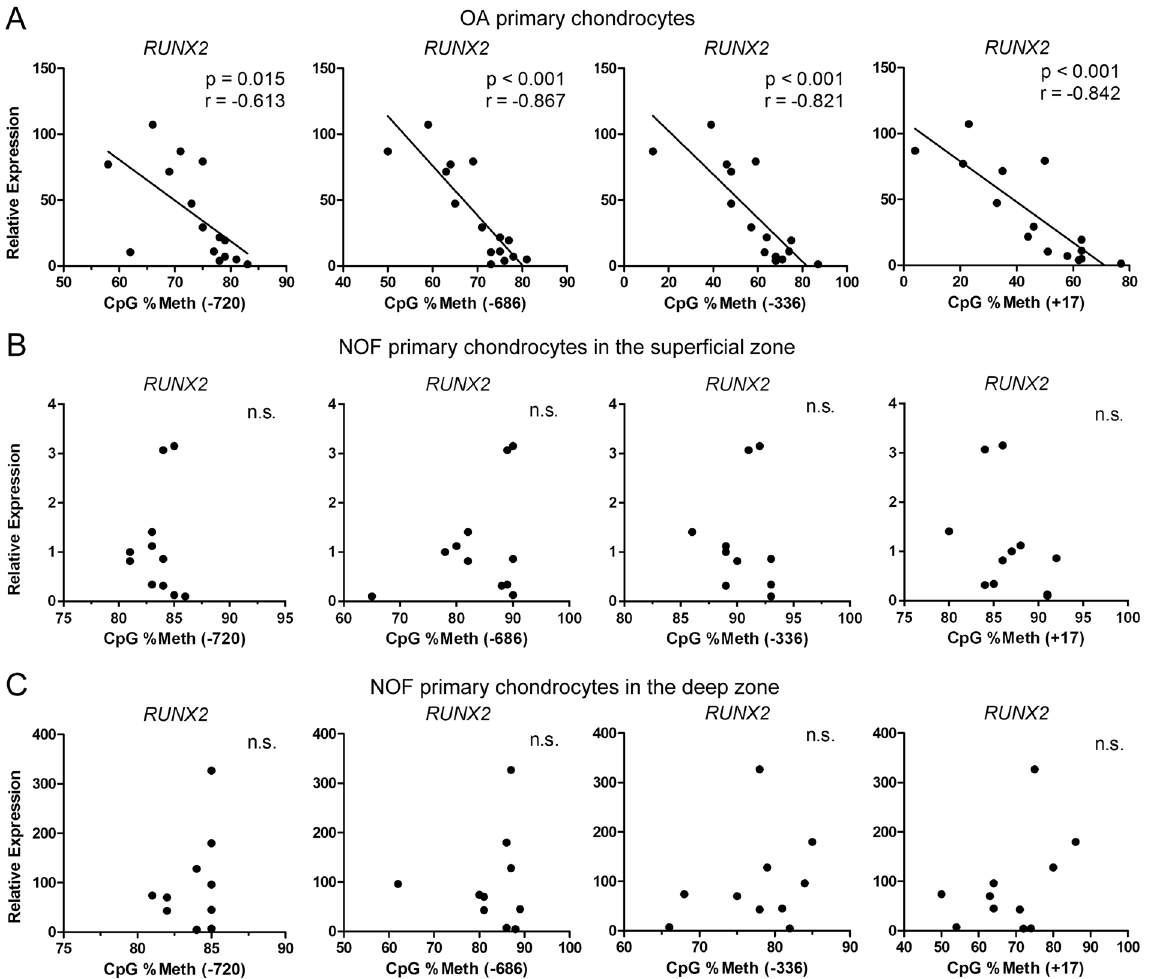
Figure 3. The percentage methylation of CpG sites in the P1 promoter correlates with RUNX2 gene expression in OA chondrocytes. Spearman’s rank correlation coefficient was used to compare the relative mRNA expression of RUNX2 and methylation status of the indicated CpG sites in the RUNX2 P1 promoter in osteoarthritic chondrocytes ( A ) and NOF chondrocytes from the superficial zone ( B ) and deep zone ( C